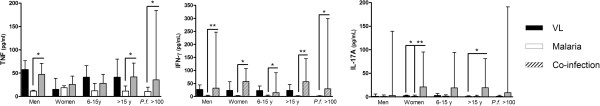
Cytokines from patients with VL and/or malaria matched by sex, age and P. falciparum parasitaemia. Cytokine levels in each group are shown as median and interquartile range. P <0.05*; P <0.01**. 6-15y = age 6-15 years; >15y = age >15 years; P.f. >100 = P. falciparum parasitaemia >100 parasites/μL.